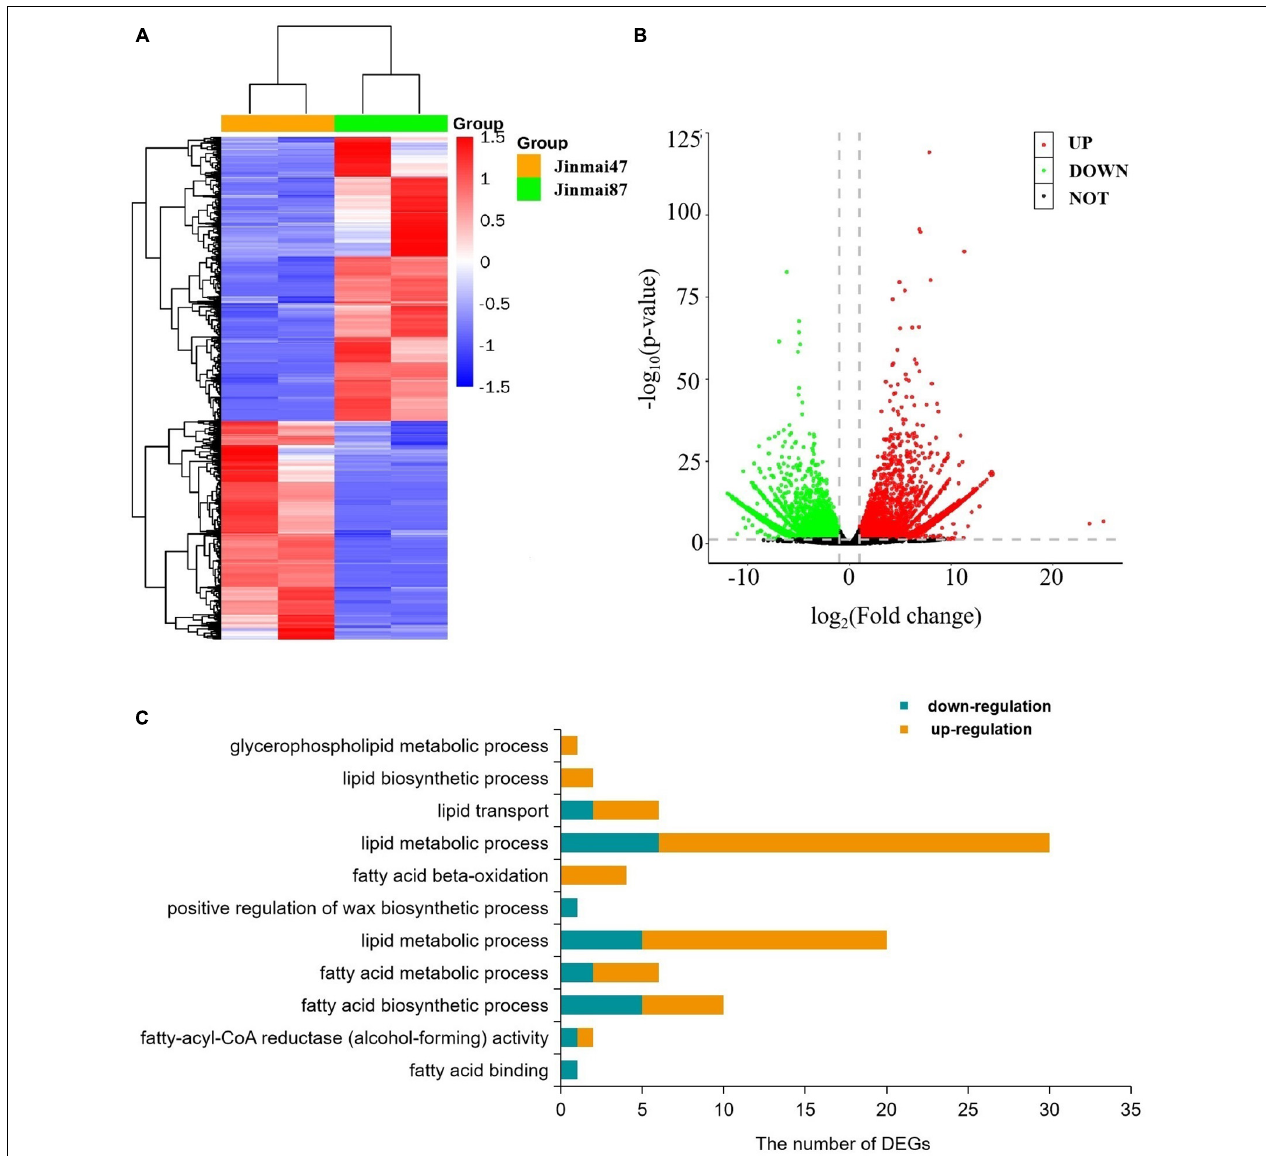
FIGURE 4 | Transcriptome data analysis. (A) Heatmap of differentially expressed genes. Each column represents a sample (two biological replicates) and each row represents a gene. (B) Volcano plot of differentially expressed genes. (C) Gene Ontology (GO) based enrichment analysis ( P -value ≤ 0.05) of differentially expressed genes (DEGs) where the X -axis represents GO terms and the Y -axis indicates the number of